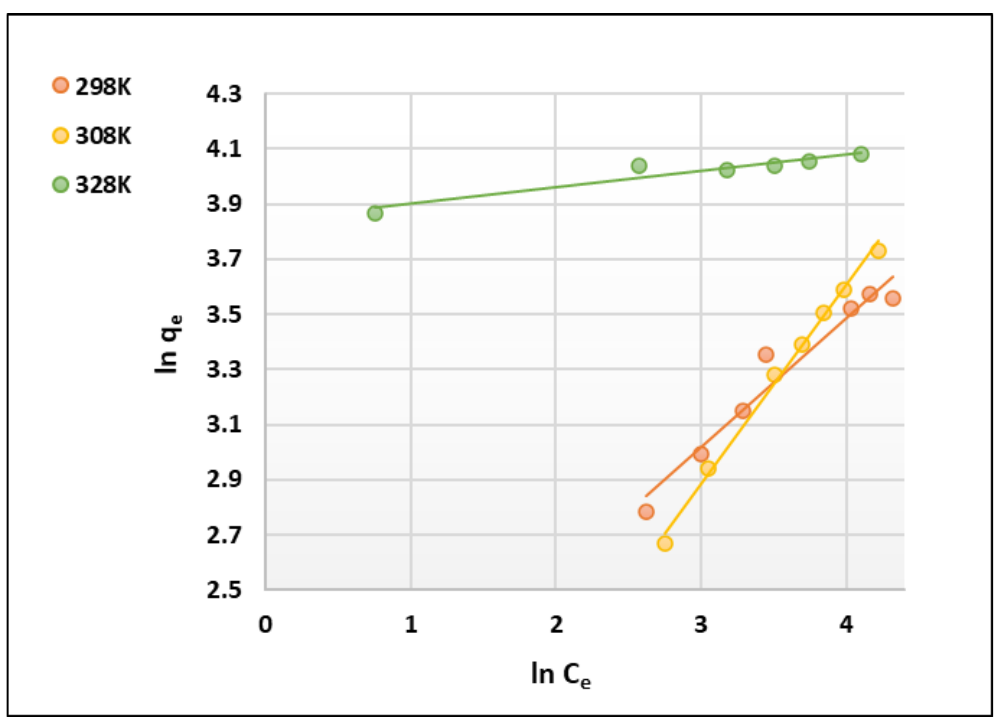
Figure 20. The plots of Freundlich isotherm for CR dye adsorption onto 2Clph-BU-Cs adsorbent (m = 0.01 g, C 0 = 30–120 mg L −1 , V = 100 mL, pH = 4, and time = 48 h).